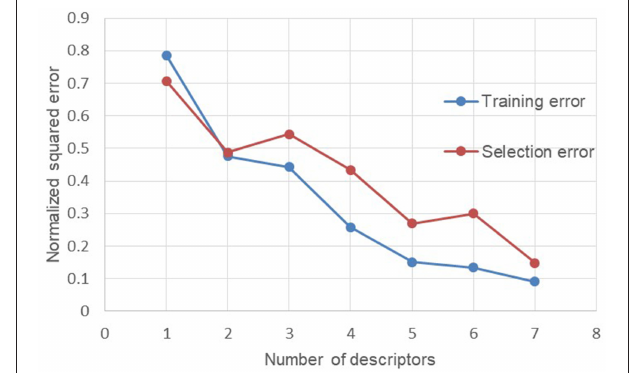
FIGURE 3 | Evolution of the normalized squared error depending of descriptors used for training.